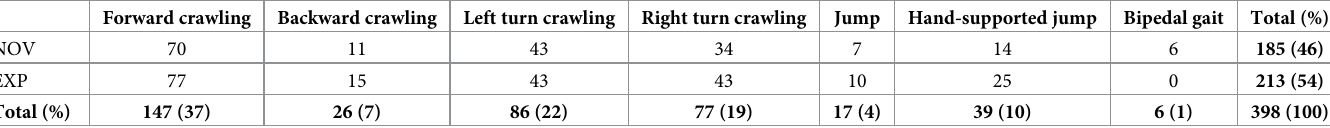
Table 3. Choice of movements. The first column represents the group within this study’s population: novice (NOV) and experienced (EXP). The next columns represent respectively the number of forward crawling, backward crawling, left turn crawling, right turn crawling, jumping movements, hand-supported jumps and bipedal gait pat- terns the performers used during the Cat exercise. The last column and line show the total values. Forward